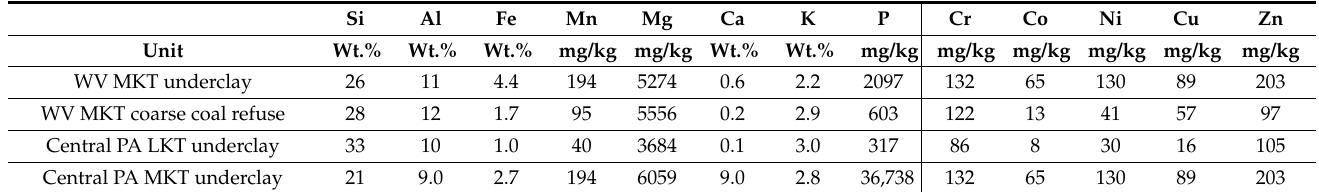
Table 4. Bulk chemistry of major and minor elements in underclays. Units are reported in wt.% or mg/kg based on